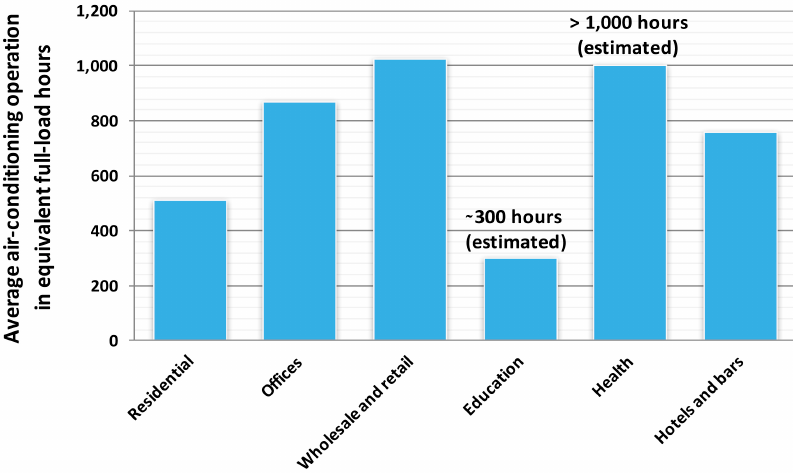
Figure 8. Distribution of average AC equivalent full-load hours per sector, EU15 (see references in the Appendix A, Table A2).